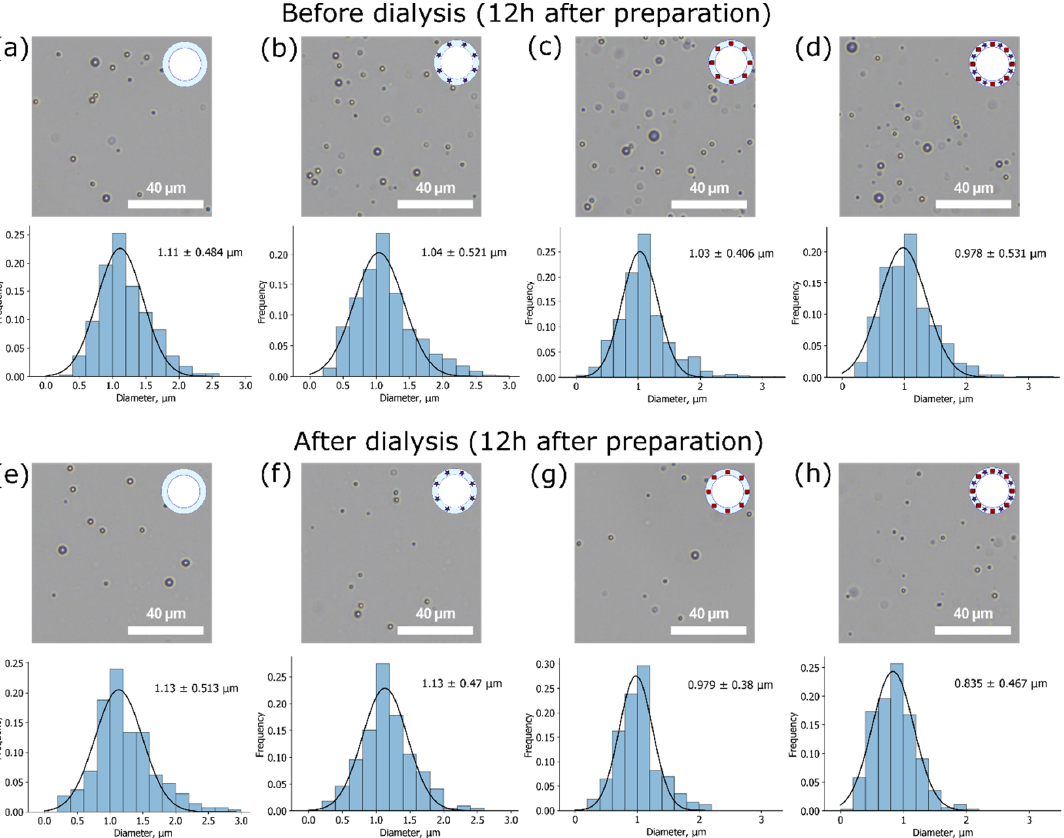
Figure 4. Optical microscopy (OM) images and microbubbles size distributions at 12 h after the preparation. Before dialysis: ( a ) BSA MBs, ( b ) BSA-ZnPc MBs, ( c ) BSA-Au MBs, ( d ) BSA-Au-ZnPc MBs; after dialysis: ( e ) BSA MBs, ( f ) BSA-ZnPc MBs, ( g ) BSA-Au MBs, ( h ) BSA-Au-ZnPc MBs.